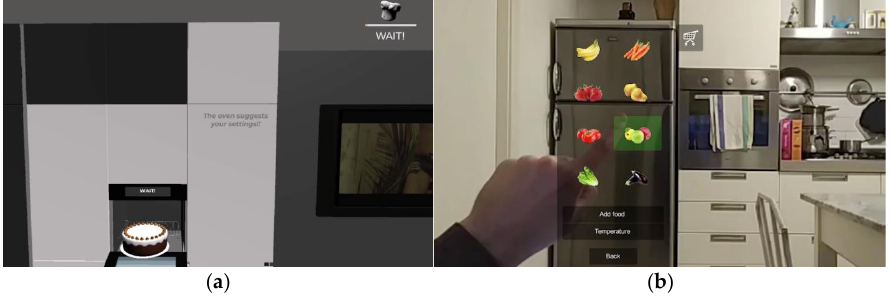
Figure 11. ( a ) Oven GUI; ( b ) fridge GUI.